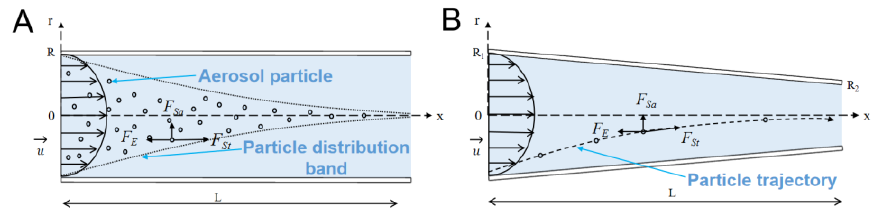
Figure 1. Schematic diagram of the particle focusing and the dominant forces exerted on the aerosol particle ( A ) in the straight microchannel and ( B ) in the converging microchannel.